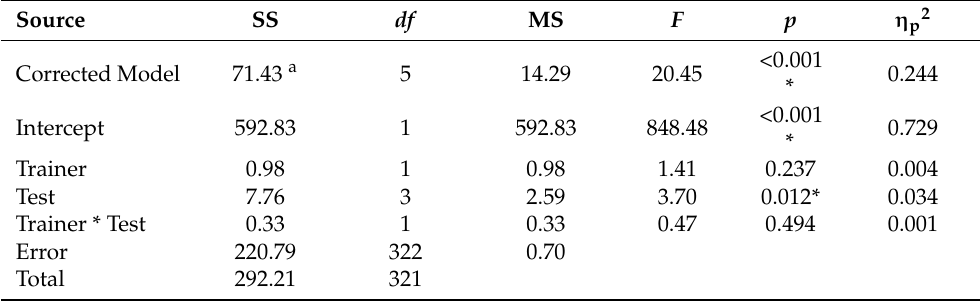
Table 3. Two-way ANOVA for trauma-informed techniques by trainer and test type ( n = 321). Source